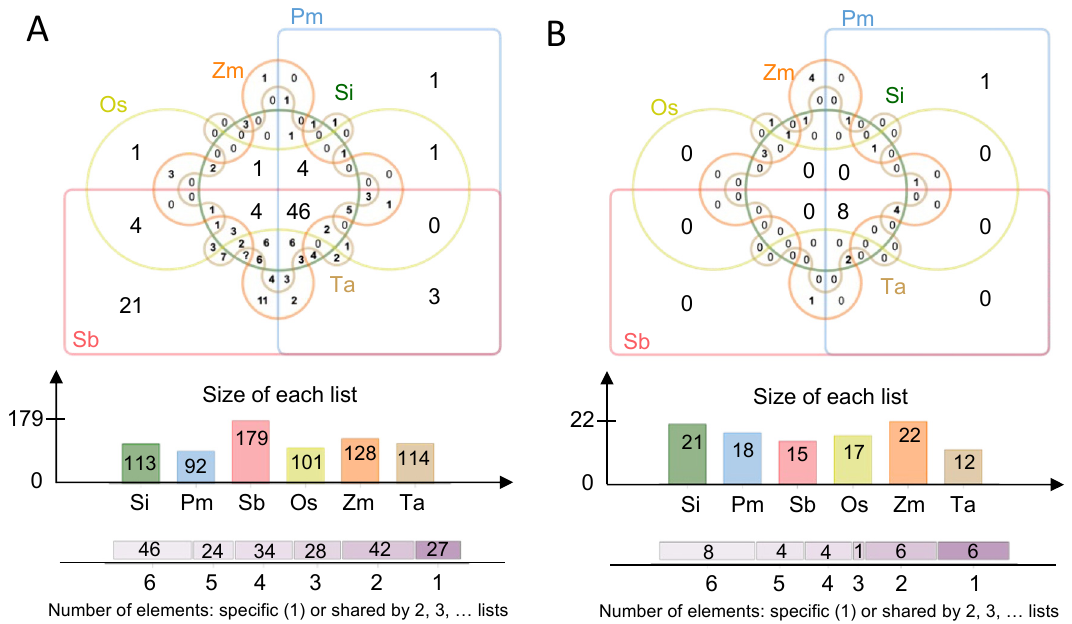
Figure 3. Venn diagram showing the number of flavonoids ( A ) and carotenoids ( B ) in the six species.